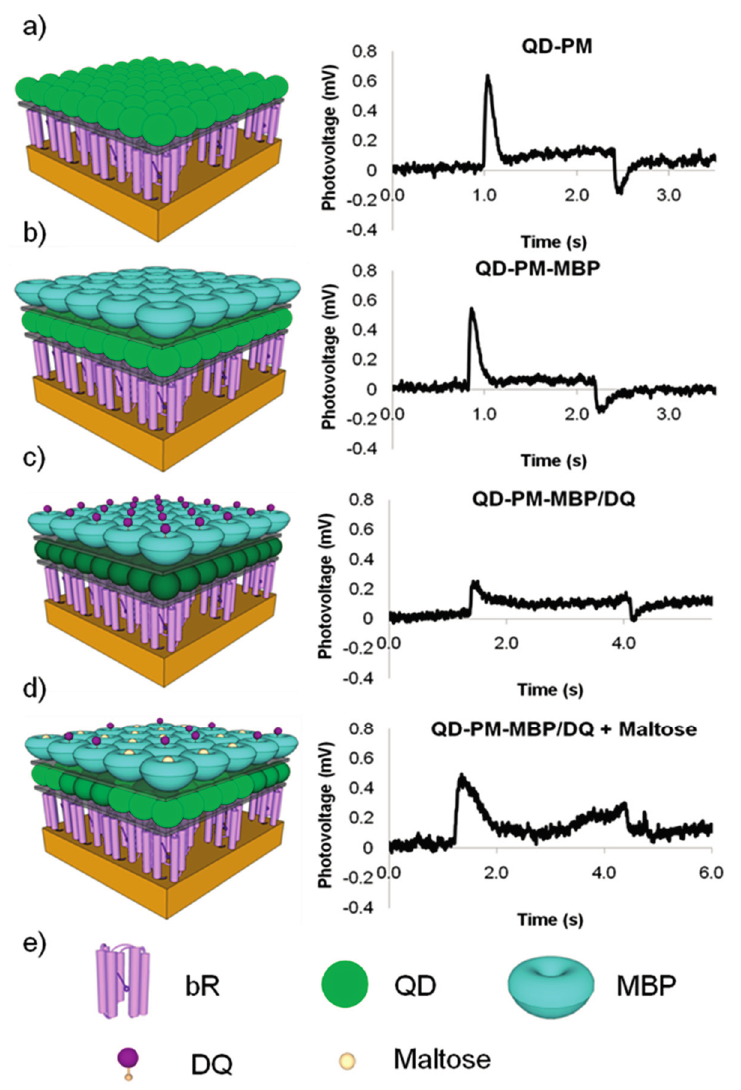
Figure 4. QD-bR hybrid sensor with ( a ) base bR-QD bioelectronic platform output; ( b ) output following the addition of a MBP layer to create the bR-QD-MBP electrode; ( c ) dropping the bR’s photoelectric output upon dark quencher binding; and ( d ) restoration of the bR photovoltage to near original magnitudes; ( e ) Legend for